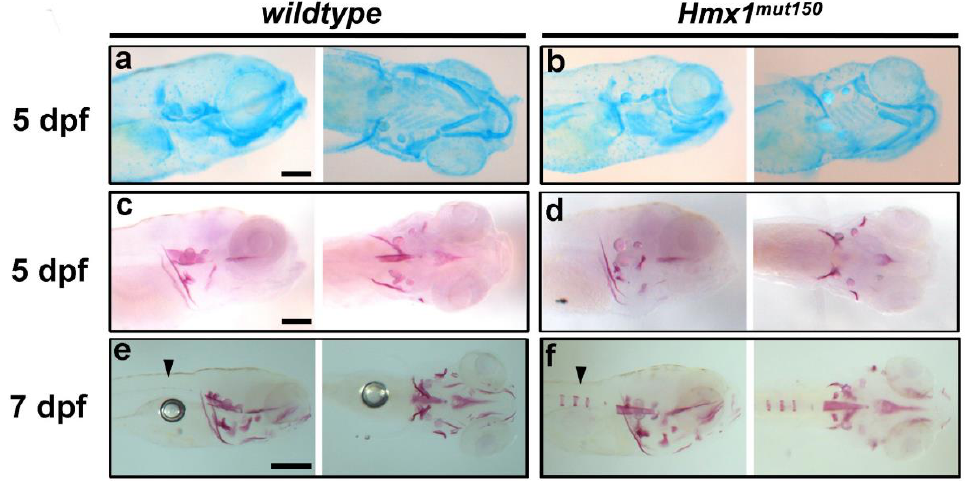
Figure 2. Precocious vertebral bone development in hmx1 mut150 zebrafish embryos: Cartilage struc- tures stained with alcian blue in wildtype and hmx1 mut150 embryos ( a , b ) at 5 dpf; the developing cranial cartilage structures develop properly in hmx1 -mutant embryos. Cranial bone structures stained with alizarin red in wildtype and hmx1 mut150 at 5 and 7 dpf ( c , f ). Wildtype and hmx1 mut150 cranial bones developed regularly at 5 dpf ( c , d ), while at 7 dpf early mineralization of the vertebrae was detected in hmx1 mut150 , similarly to hmx1 mut10 embryos ( e , f ). Bar, ( a – c ) 250 μ m; ( e – f ) 500 μ m.